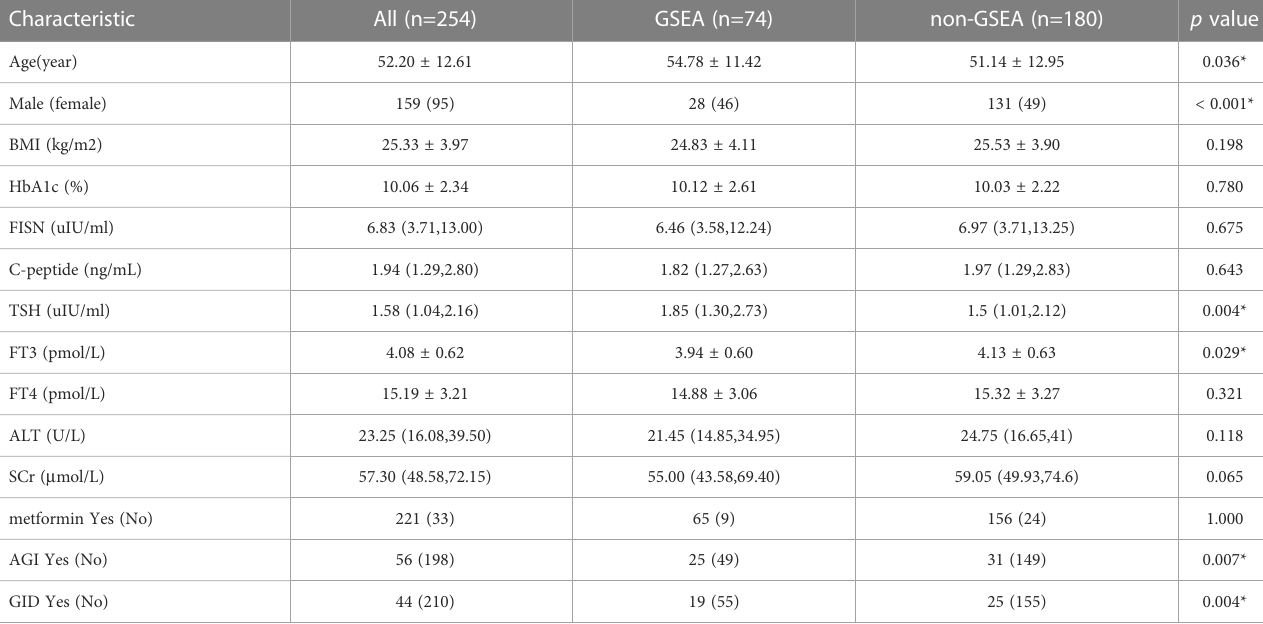
TABLE 1 Baseline characteristics and their association with reporting gastrointestinal side effects (GSEA) among patients treated with liraglutide.